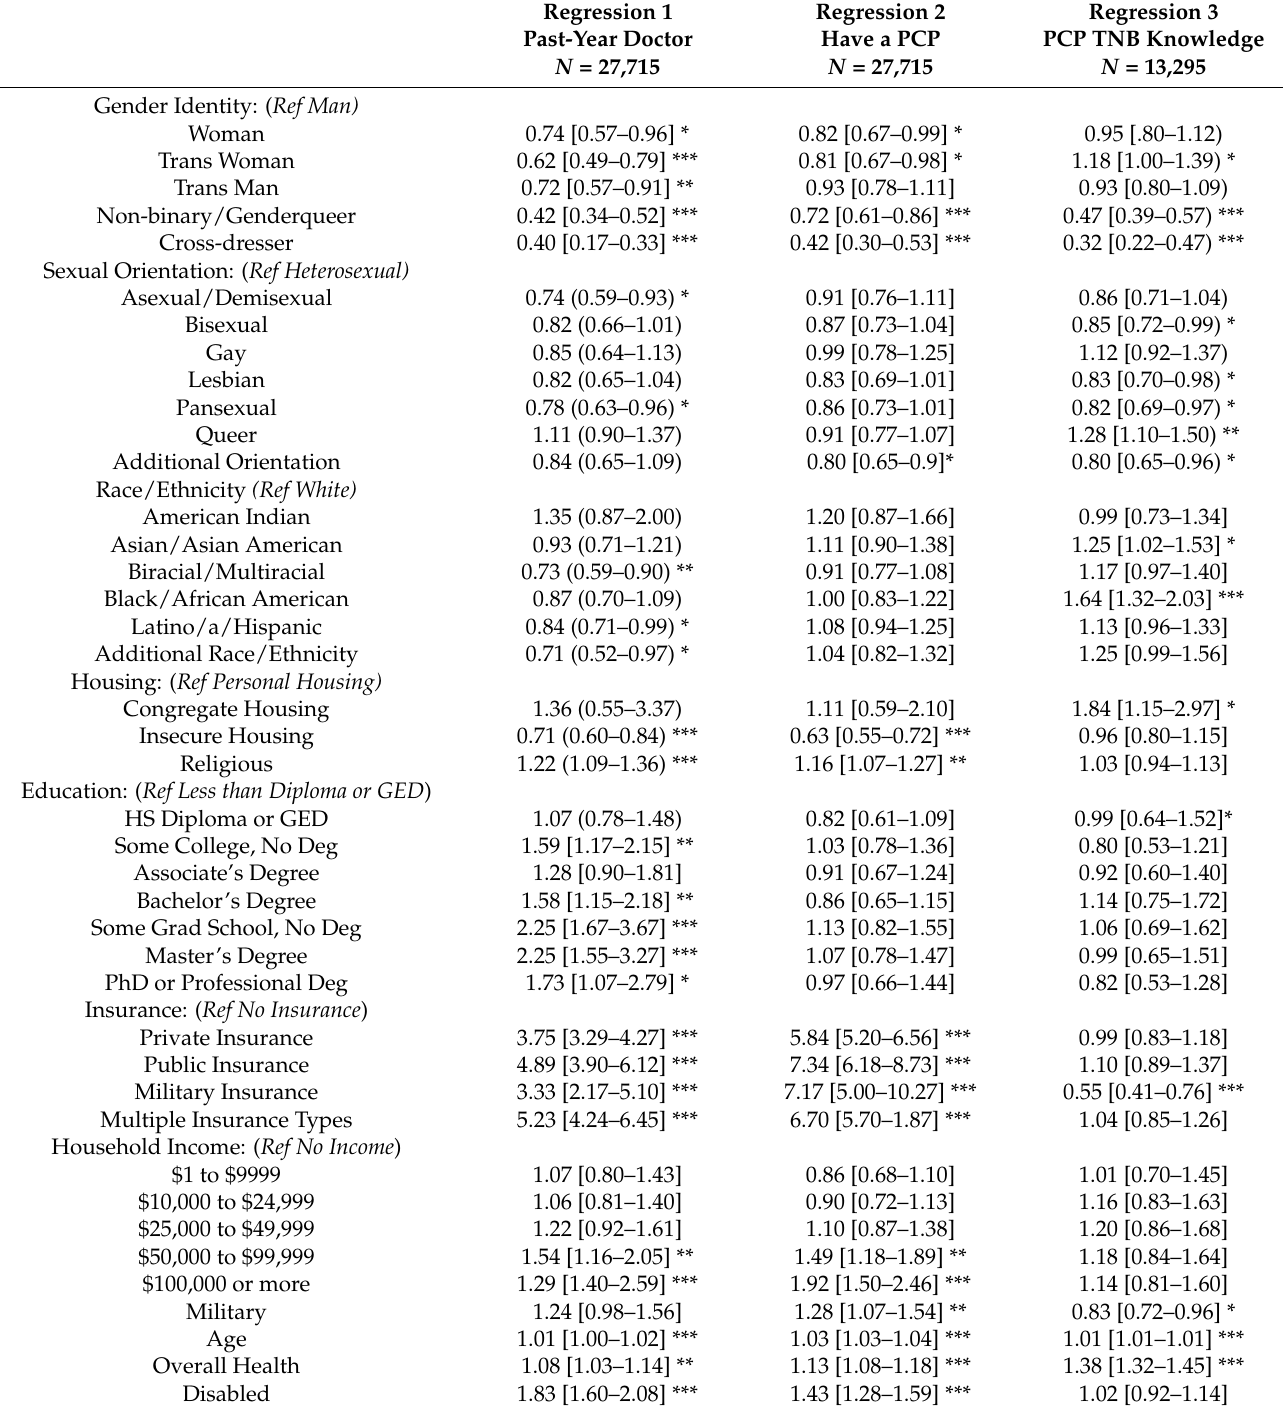
Table 2. Logistic and ordered regression models of factors correlated with having seen a doctor in the past year, having a PCP, and how knowledgeable a PCP is about TNB